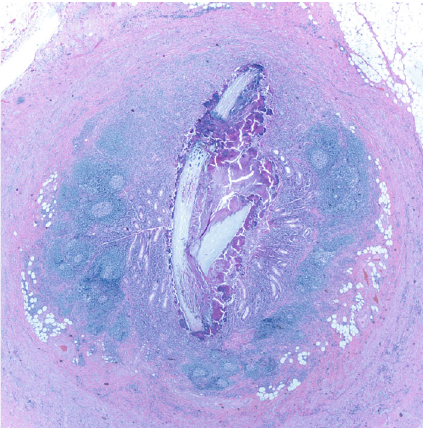
Figure 1: H&E showing a nail in the lumen of the appendix (2x).